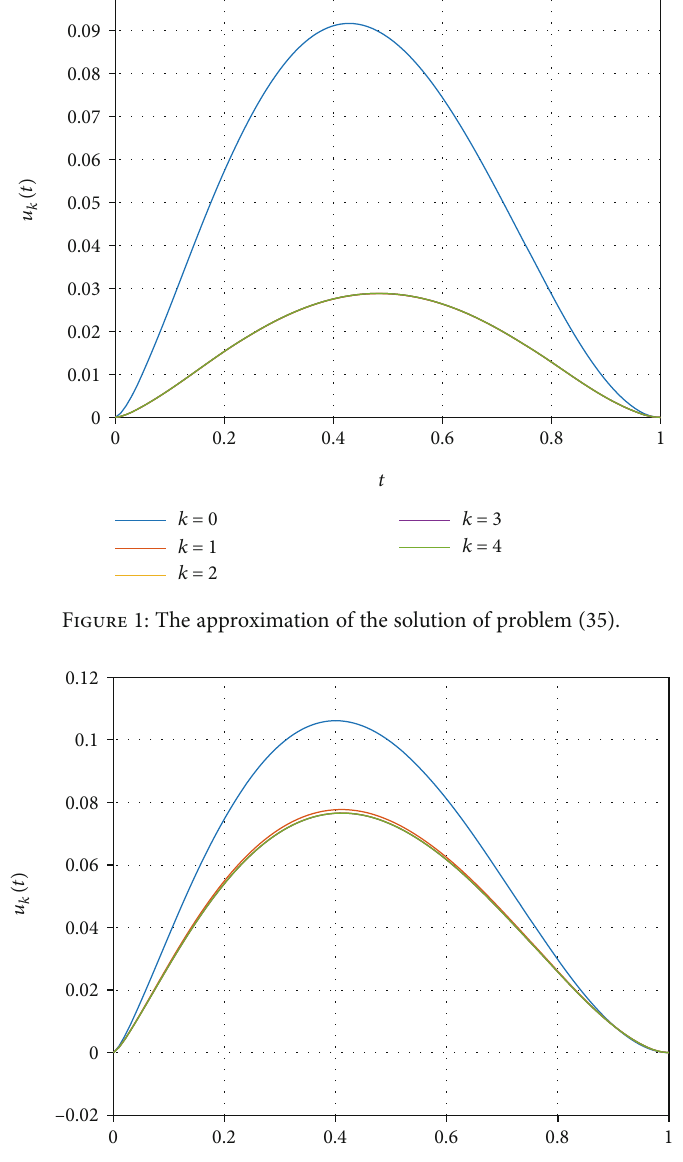
Figure 2. Data Availability